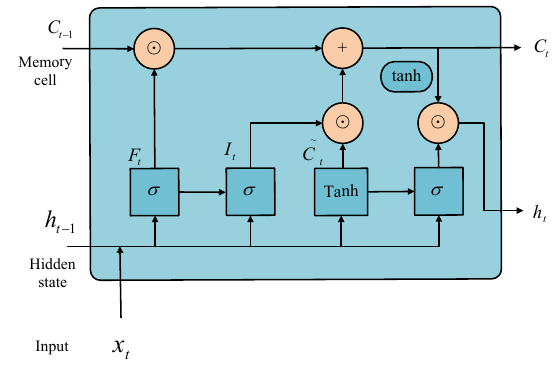
Figure 3. Structure of